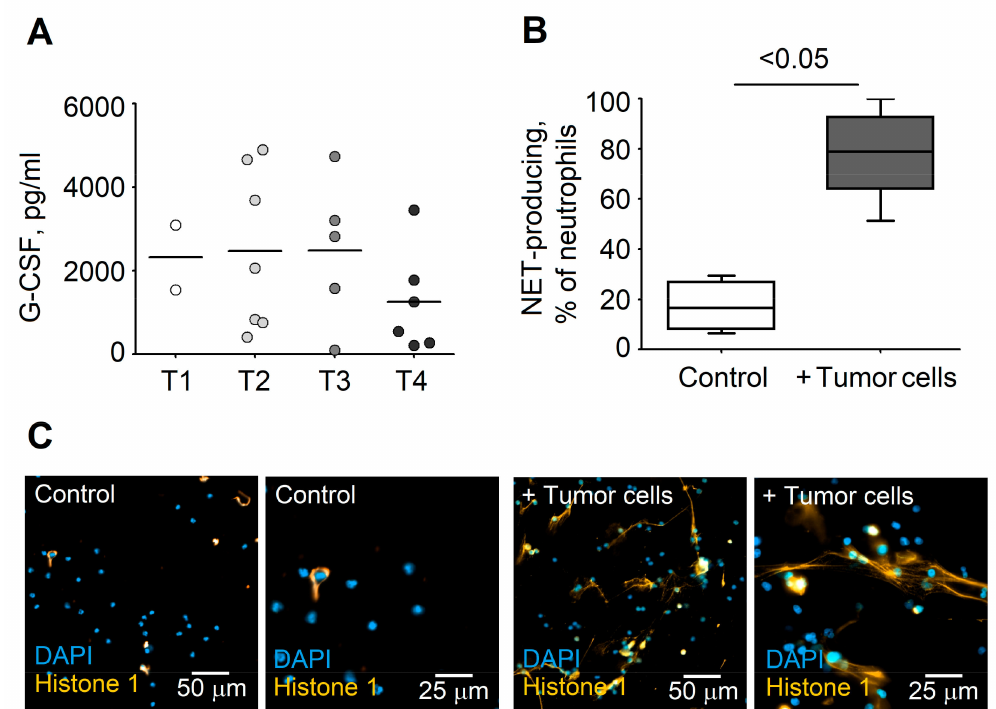
Figure 5. Tumor cells produce high levels of G-CSF and stimulate NETosis of blood neutrophils. ( A ) G-CSF levels in supernatants of cultured tumor tissue (normalized to sample mass). Data are shown as individual values and mean. ( B , C ) Elevated NET production by neutrophils co-incubated with tumor cells. Quantification of NET-positive neutrophils ( B ), and exemplified pictures showing NET release by HNC blood neutrophils ( C ). Isolated neutrophils and tumor cells of HNC patients were co-incubated at a 1:1 proportion for 4 h, fixed, and stained with DAPI (blue) and anti-histone-1 antibodies (orange); scale bars 50 and 25 µ m. For comparisons of two independent groups, a Mann–Whitney U-test was used. Data are shown as median, interquartile range, and minimal and maximal